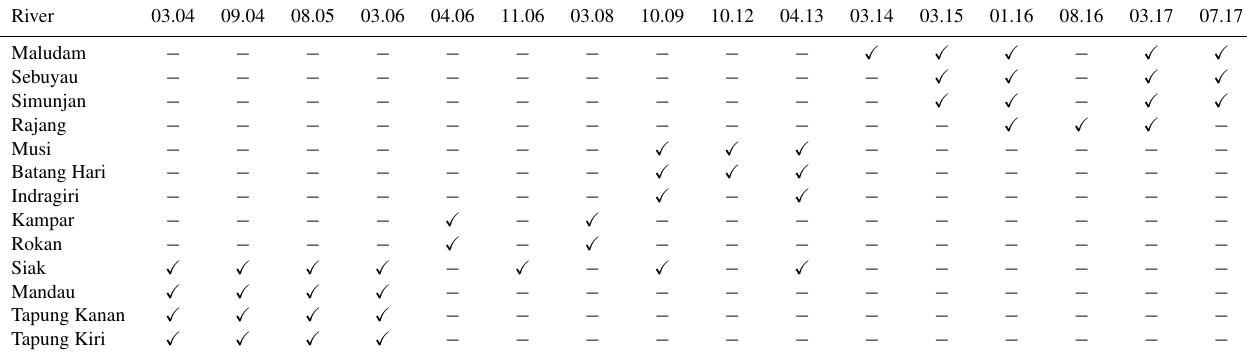
Table A1. List of river